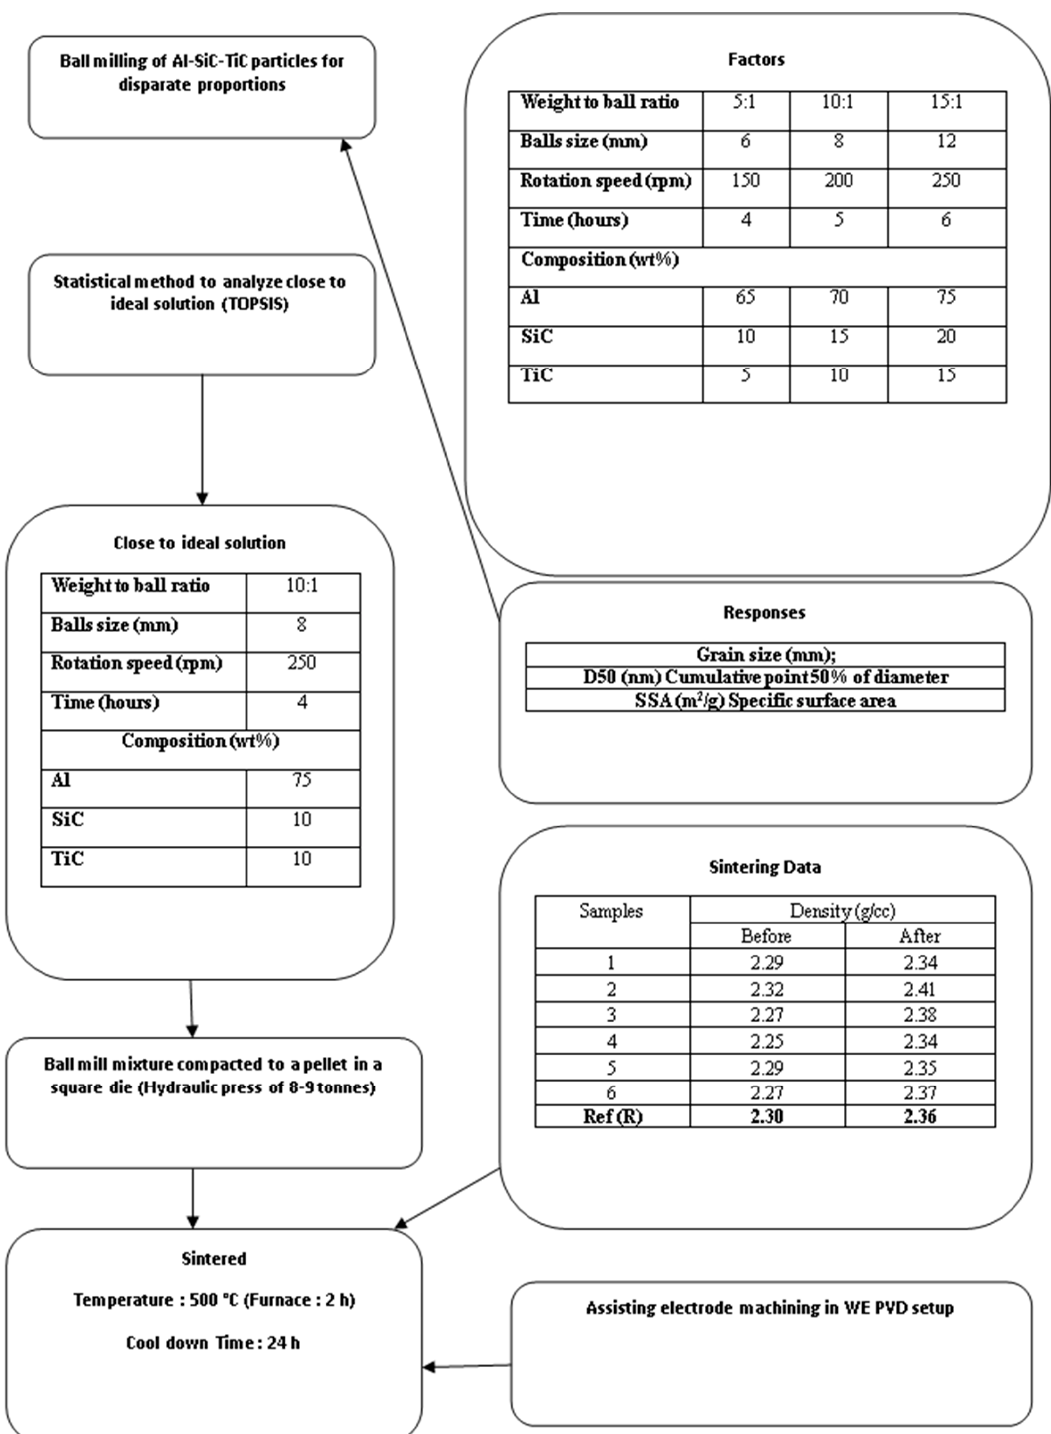
Figure 4. Methodology for processing of the Al-SiC-TiC metal matrix composite.